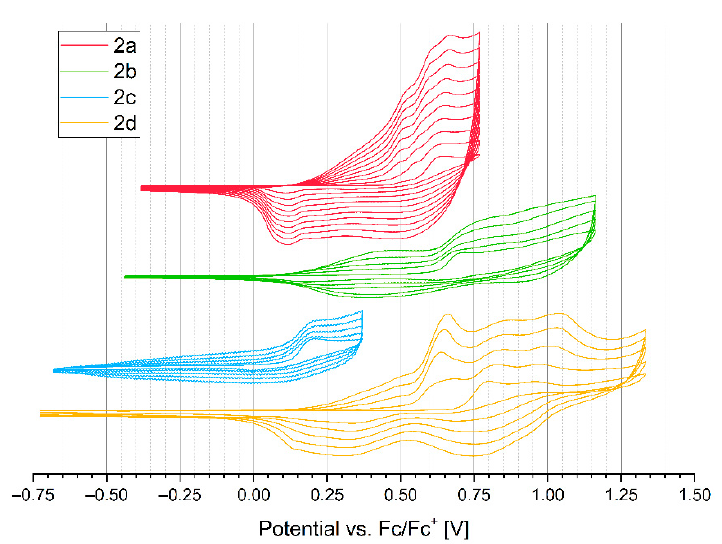
Figure 4. Cyclic polymerization versus ferrocene redox couple, concentration 1 mmol/dm 3 in DCM, 100 mV/s.